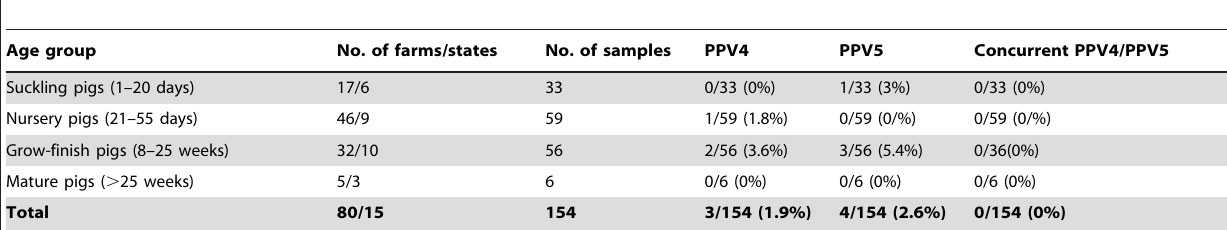
Table 2. Summary of the history (age, states, farms) and prevalence of PPV4, PPV5 or concurrent PPV4/5 DNA in 185 fecal samples from pigs in the U.S.